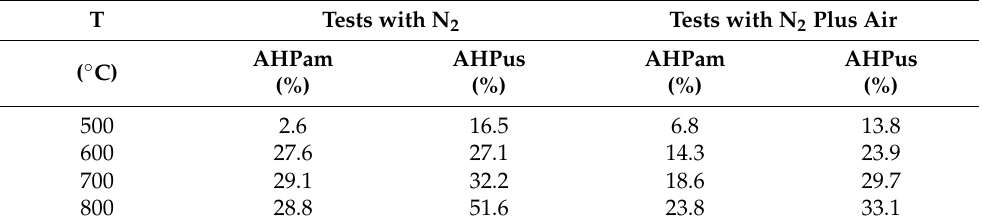
Table 6. Cold gas efficiency ( ξ , Equation (4)) for each set “material kind/fluidizing agent/bed temperature”.